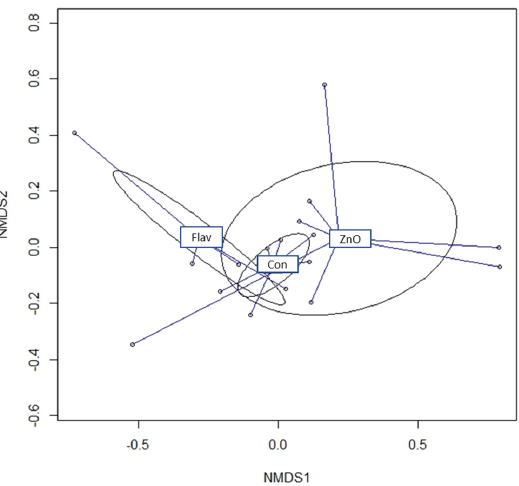
Table 5. Evenness and diversity of colon microbiota of weaned pigs fed experimental diets 1 .